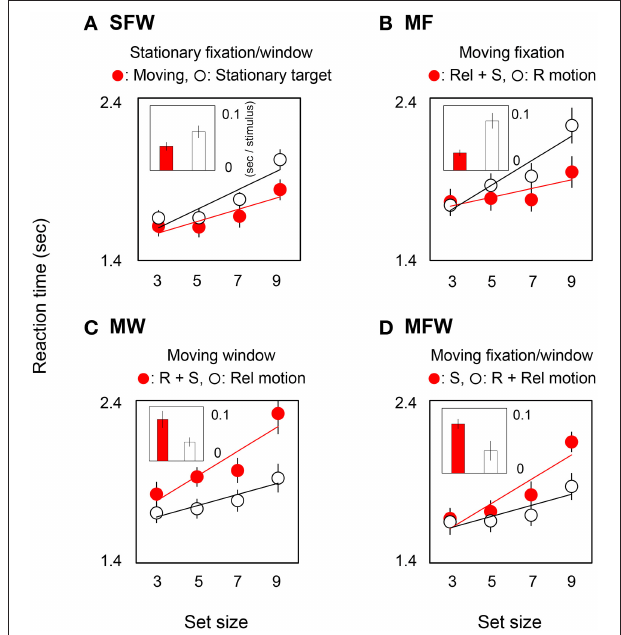
FIGURE 3 | Reaction times and slopes in target-absent searches for each (A: SFW, B: MF, C: MW, D: MFW) condition. See explanation in Figure 2